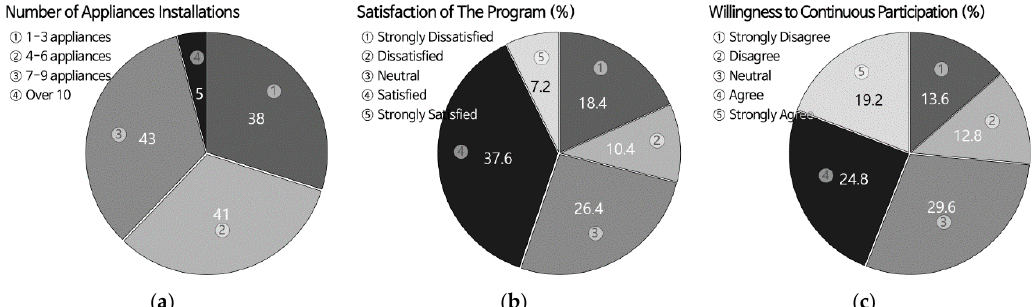
Figure 2. Results: ( a ) Number of installed smart plugs and switches; ( b ) satisfaction with the program; and ( c ) willingness to continue to